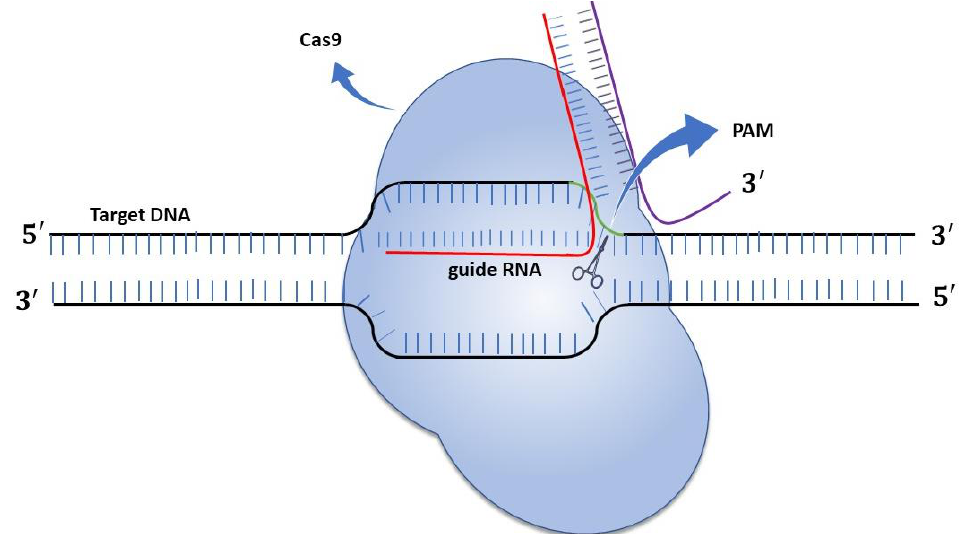
Figure 5. In the CRISPR/Cas9 system, the Cas9 endonucleases are directed to their target by a section of gRNA. The gRNA fragment that accompanies the DNA is between 18 and 20 nucleotides long. The cut consists of 2 and 6 nucleotides (the exact sequence depends on the Cas enzyme) located at the 3 ’ end of the gRNA, known as the protospacer adjacent motif (PAM).